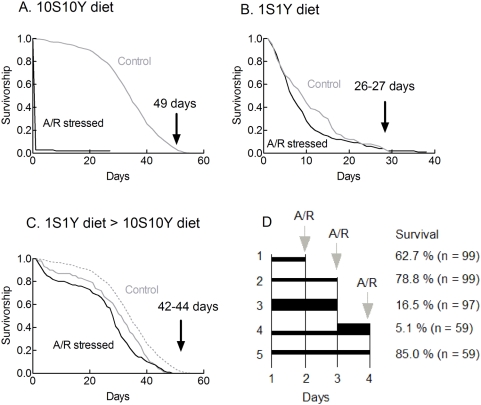
A severe dietary restriction protects flies against A/R injuries.A. Fed flies were anoxia sensitive. One day old flies were fed on a rich 10S10Y diet. After 2 days, flies were exposed to 3.5 hours of severe anoxia (<0.1% O2) and reoxygenated. The survivorship curve (black) is compared to that of normoxic flies on the same diet (grey). Few flies (∼3%) recovered from the A/R stress. The largest mortality as compared to the experiments shown in Figure 1 was due to the use of more severe anoxic conditions (0.1% O2 versus 1% O2). Sample sizes were 109 (controls) and 120 (A/R stressed flies). B. Dietary restricted flies were anoxia resistant. One day old flies were fed on a poor 1S1Y diet. After 2 days, flies were exposed to 3.5 hours of anoxia, reoxygenated and maintained on the same 1S1Y diet. The survivorship curve (black) is compared to that of normoxic flies maintained on a 1S1Y diet (grey). P = 0.0095 using the Log rank test. Mean longevities were 10.2±0.77 days (n = 98) and 8.43±0.50 days (n = 219) for control and A/R stressed flies respectively. C. An assay for the diet dependent tolerance to A/R stresses. Survivorship curves of three groups of flies are compared. Grey continuous curve: One day old flies were fed on a 1S1Y diet and switched after 2 days to a 10S10Y diet. Black curve. One day old flies were fed for 2 days on a 1S1Y diet, A/R stressed (3.5 h) and switched to a 10S10Y diet. The difference between the two curves documents the influence of the A/R stress on dietary restricted flies. An A/R stress mainly increased the short term mortality. The dotted grey line shows for comparison the survivorship curve of normoxic flies maintained on a 10S10Y diet. The difference with the continuous grey line documents the action of a 1S1Y to 10S10Y diet shift on longevity. The comparison shows that shifting flies from a 1S1Y diet to a 10S10Y diet rapidly restored low mortality rates. Arrows in panels A–C show maximum longevities. D. Influence of different protocols of dietary restriction on survival following an A/R stress. One day old flies were maintained on a 1S1Y diet (thin lines) or a 10S10Y diet (thick lines) for the times indicated and then exposed to a 3.5 h A/R stress. Surviving flies were scored after 48 hours. Five different experimental protocols are compared. Experiments #2 and #3 reproduced the data presented in panels A and C. Experiment #1 shows that a one day adaptation to a 1S1Y diet did not induce a maximum protection against A/R stresses. Experiment #4 shows that the protective action of a 1S1Y diet was completely lost when flies were shifted back to a 10S10Y diet for 24 hours.